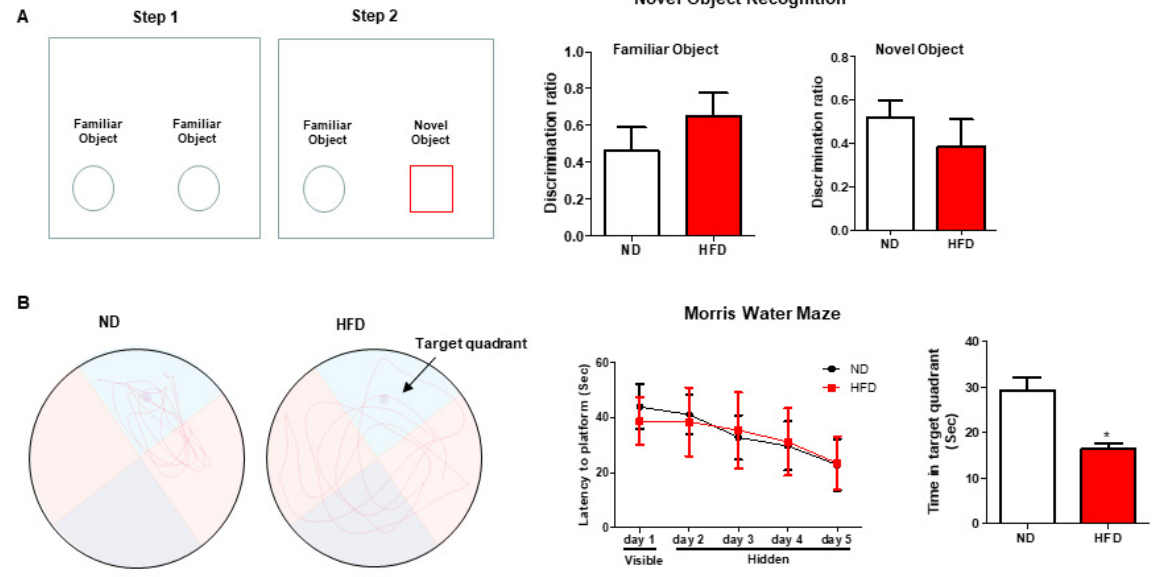
Figure 4. Effect of long-term HFD consumption on learning and memory in mice. Schematic diagram, discrimination ratio between familiar objects, and discrimination ratio between familiar object and novel object in Novel Object Recognition ( A ). Representative movement trace images, latency to platform from day 1 to day 6, and time spent in target quadrant on day 6 in Morris Water Maze ( B ). Values are shown as the mean ± SEM. T-test or one-way ANOVA with a post hoc Tukey test was performed. * p < 0.05 vs. ND.